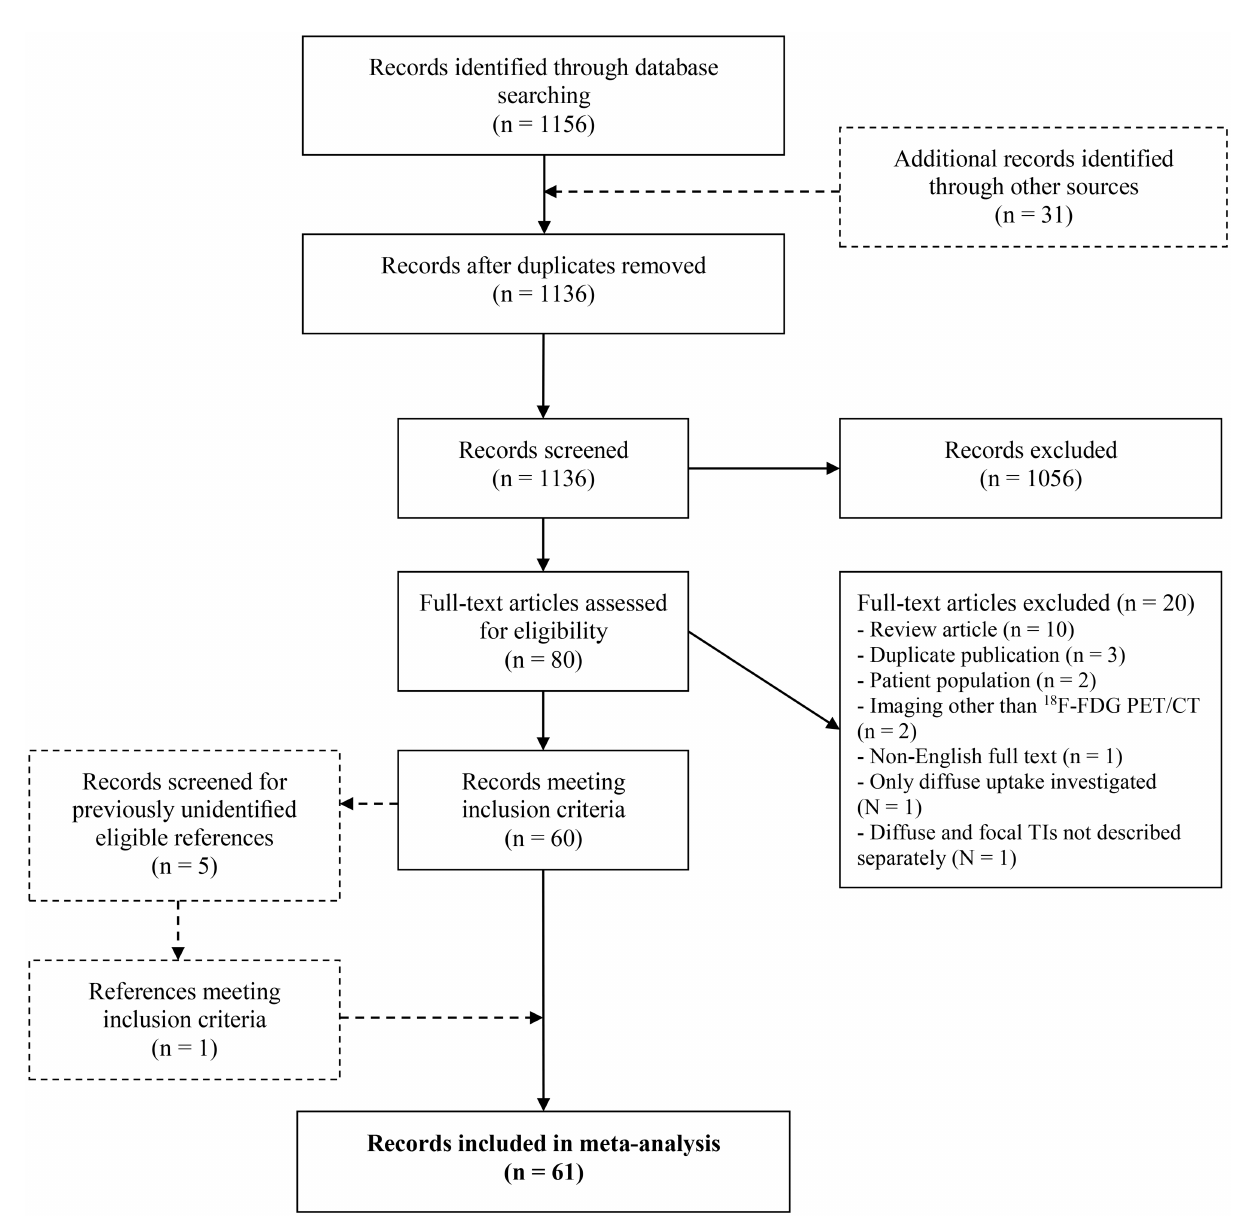
FIGURE 1 | The Preferred Reporting Items for Systematic Reviews and Meta-Analyses (PRISMA) fl ow chart. 18 F-FDG PET/CT, 18 F-Fluorodeoxyglucose Positron Emission Tomography with Computed Tomography; FTI, Focal Thyroid